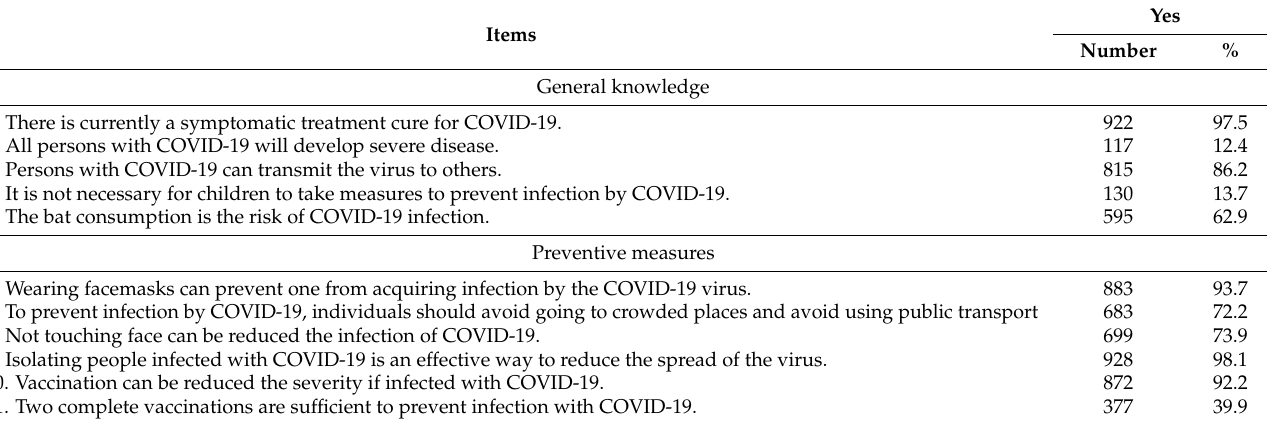
Table 3. Knowledge of COVID-19.